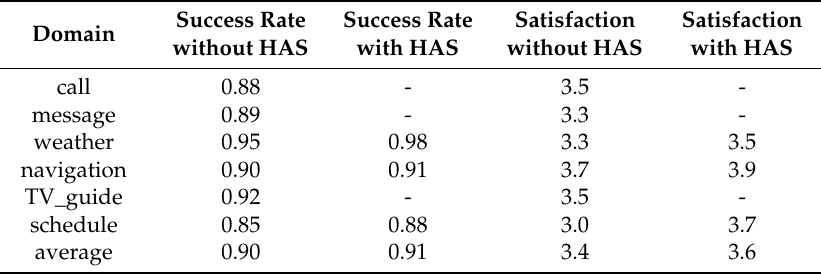
Table 3. Evaluation result of success rate and